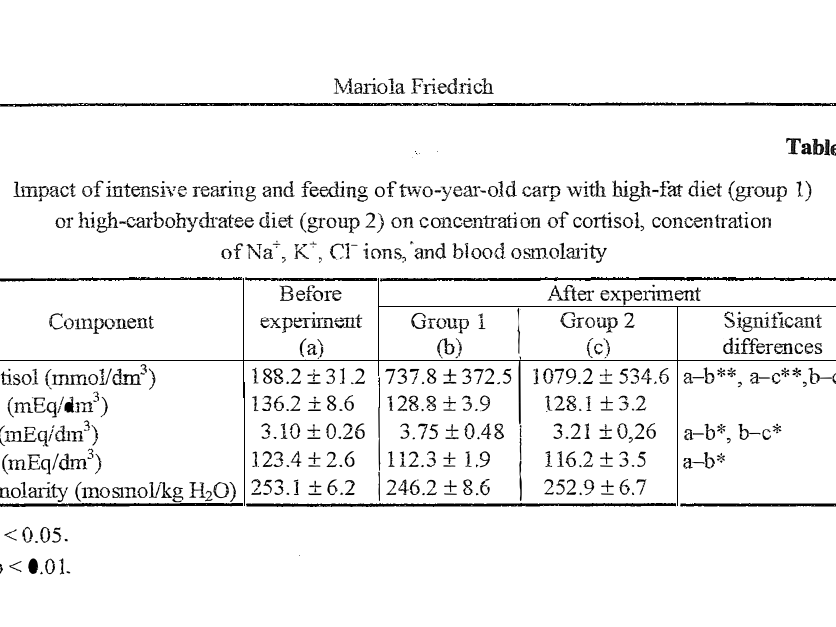
Impact of intensive rearing and feeding of two-year-old carp with high-fat diet (group l) or high-carbohydratee diet (group 2) on concentration of cortisol, concentration er Na+ of , K�, ions, 'and blood